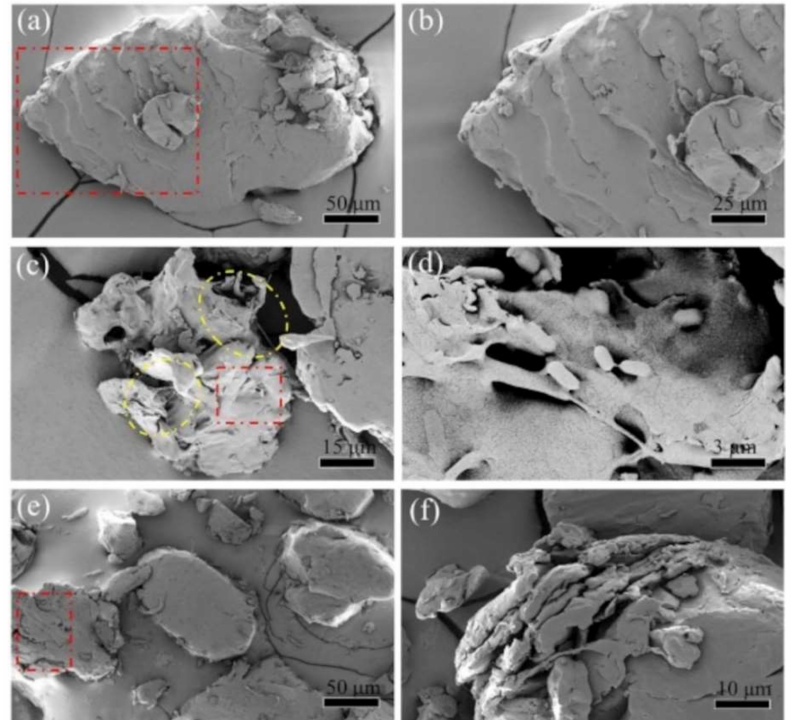
Figure 12. SEM images of sewage incubated PLA MPs before and after removing biofilms, with pris- tine PLA MPs as control. ( a ) The surface morphology of pristine PLA without any treatments. ( c ) The surface morphology of PLA MPs with incubation time for 35 days. ( e ) The surface morphology of PLA MPs after removal of adherent biofilms. The right graphs ( b – f ) exhibited surface morphology of specific areas (marked as yellow or red in ( a , c , e ), respectively) that were selected and magnified. Obtained from reference [157]. Copyright @ 2022 Elsevier, License Number: